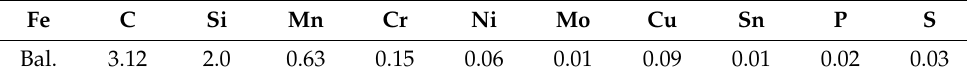
Table 1. Elemental composition of the molten bath before alloying obtained by optical emission spectrometry